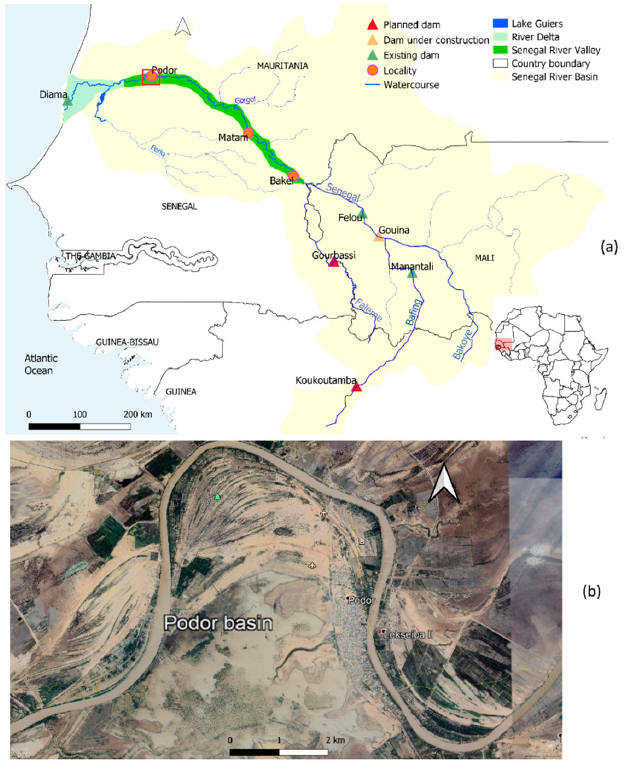
Figure 1. Senegal River Basin and Valley with the Podor basin in red square ( a ); Google Earth image of the Podor basin of 12 September 2019 ( b ).